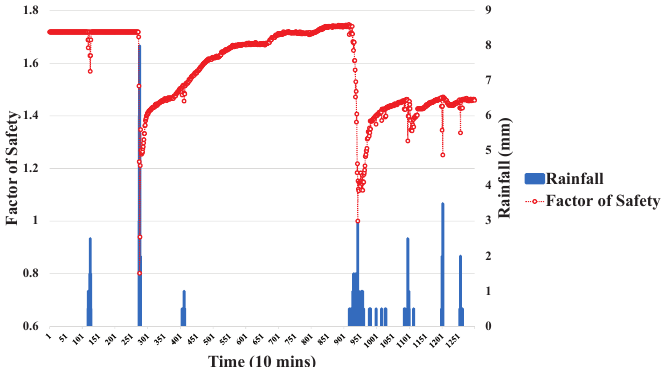
Figure 10. Monitoring curves of Factor of Safety and rainfall at Shen-Mu